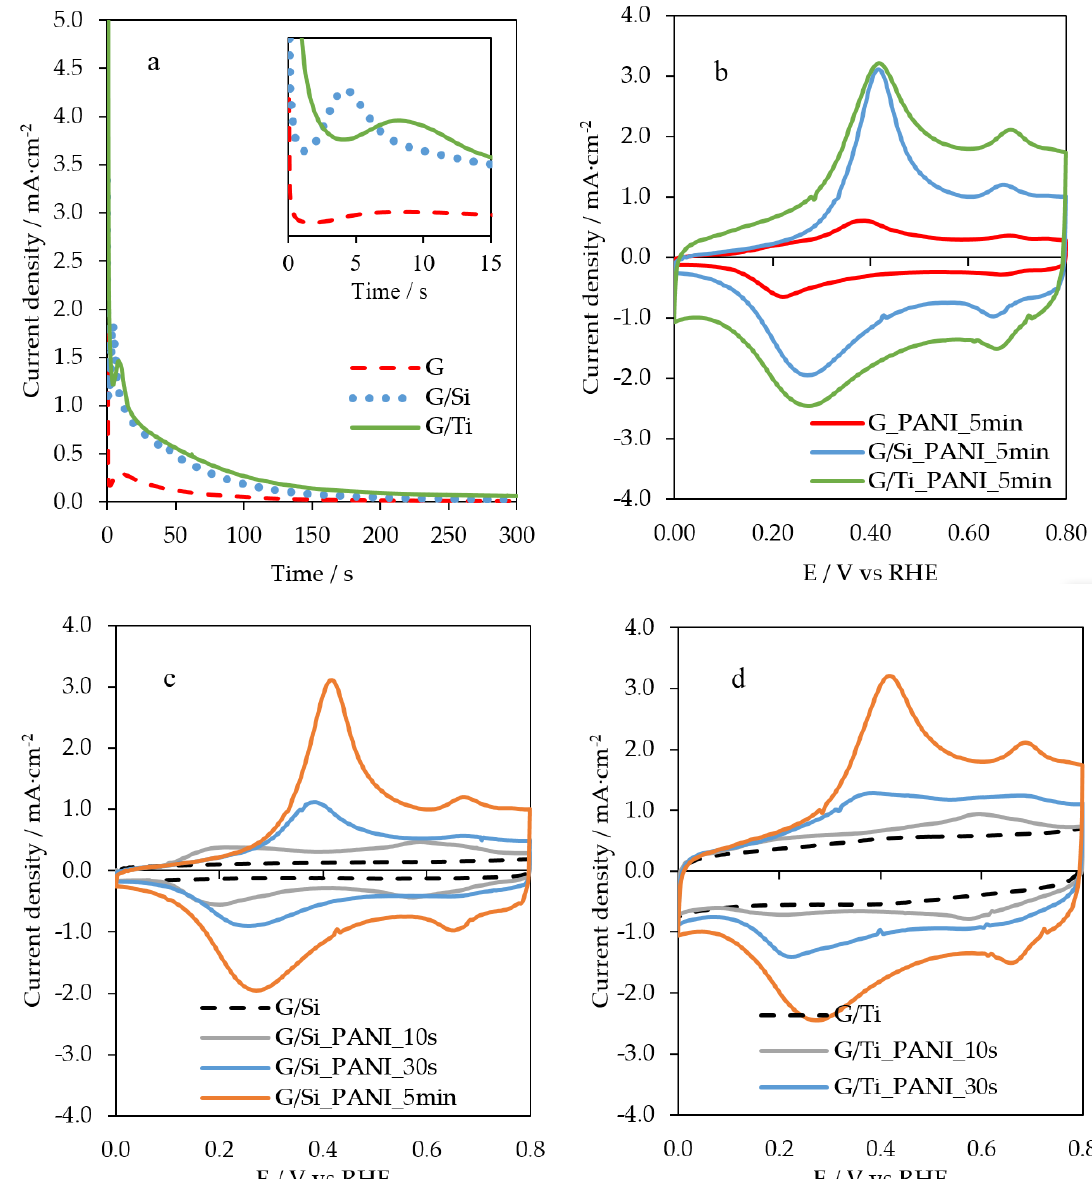
Figure 1. ( a ) Chronoamperometric profiles of aniline polymerization at 0.95 V vs. RHE during 5 min on G, G/Si, and G/Ti, ( b ) CV profiles of the resultant samples (G, G/Si, G/Ti) after 5 min of aniline polymerization, ( c , d ) CV profiles of all G/Si-PANI-X and G/Ti-PANI-X samples, respectively. Scan ( c , d ) CV profiles of all G / Si-PANI-X and G / Ti-PANI-X samples, respectively. Scan rate = 50 mV · s − 1 rate = 50 mV·s −1 ; 0.1 M H 2 SO 4 .